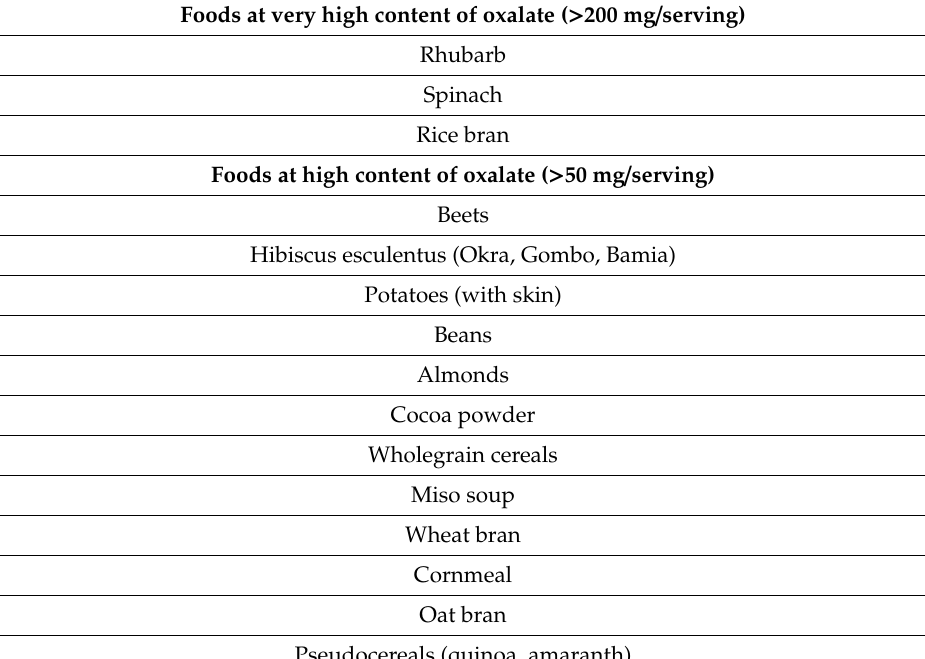
Table 4. List of foods rich in